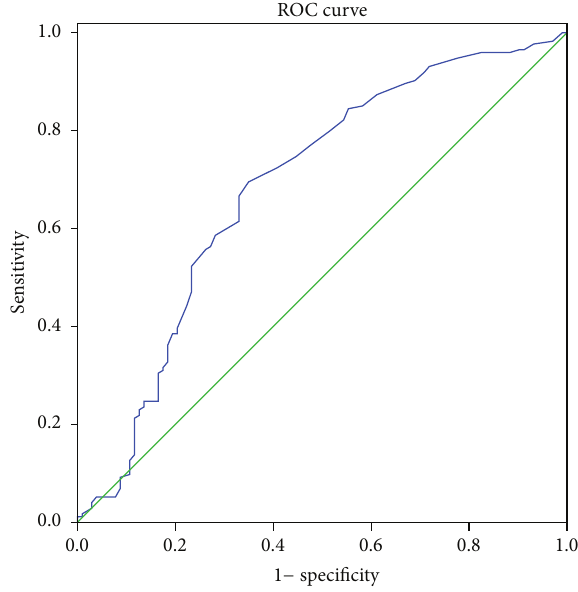
Figure 3: ROC curve for CSS prediction. A ROC curve plots the sensitivity on the 𝑦 -axis against one minus the specificity on the Figure 1: The histogram of the RDW. 𝑥 -axis. The area under curve (AUC) was used as an estimation of diagnostic accuracy. The AUC was 0.684 (95% CI: 0.616–0.752, 𝑃 < 0.001 ). It demonstrated that RDW (cut-off point: 14.5%) predictssurvivalwithasensitivityof44.3%andaspecificityof77.7%. Diagonal segments are produced by